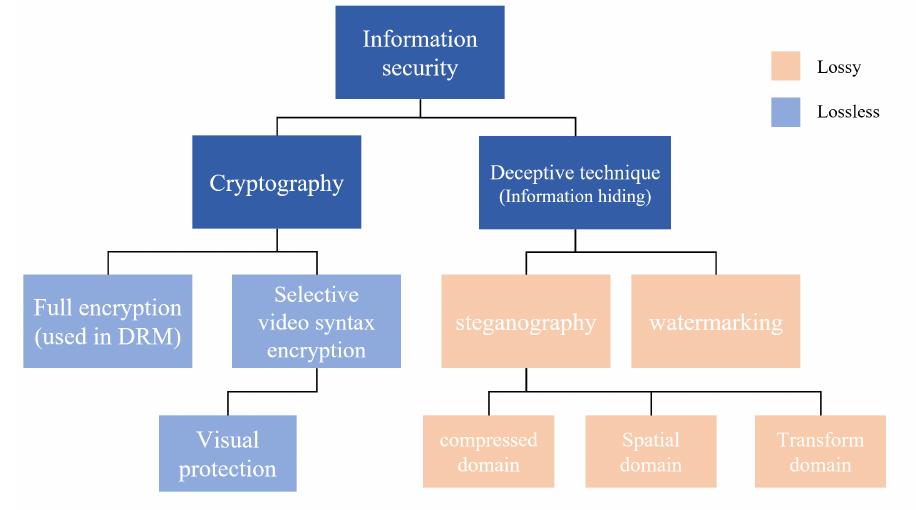
Figure 1. Types of information